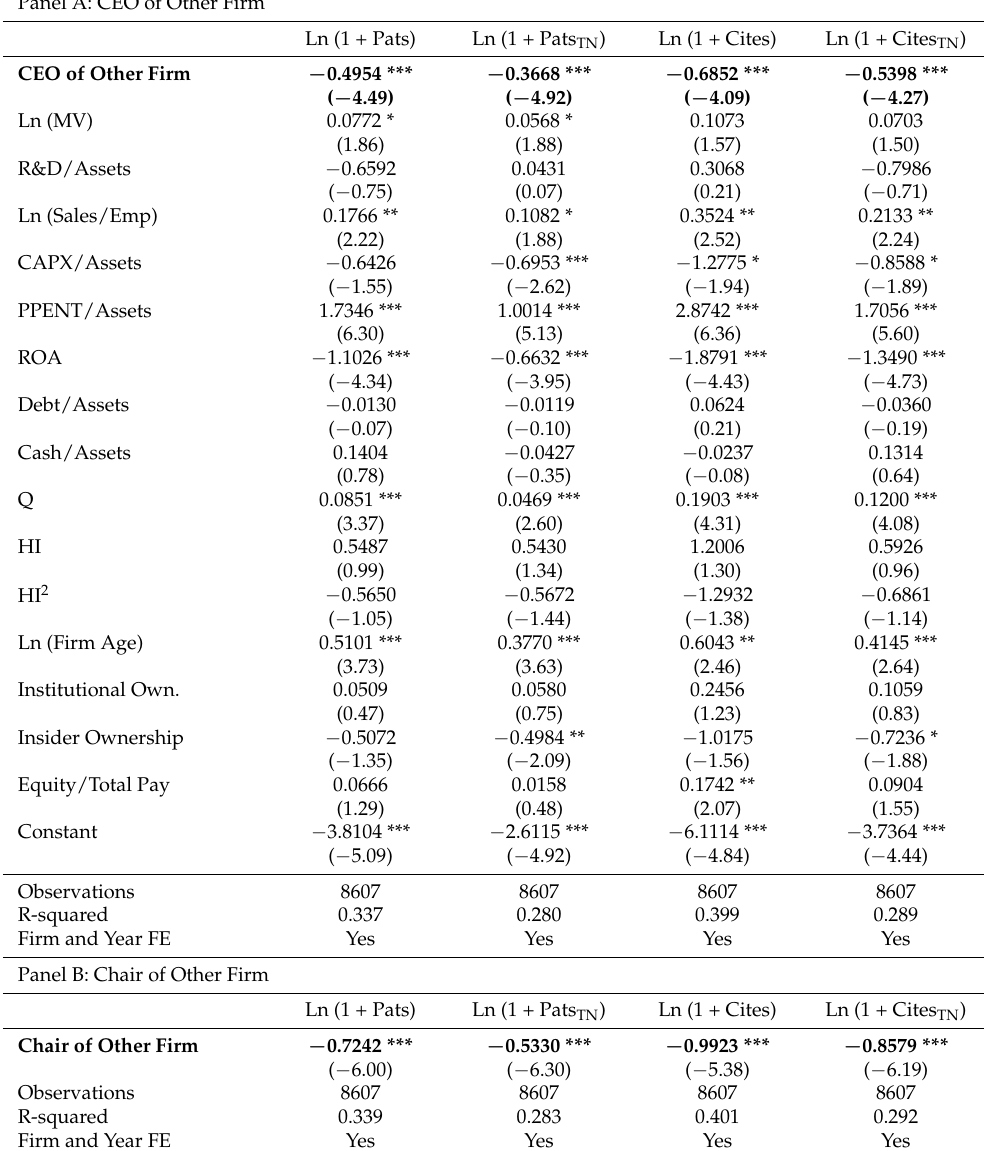
Table 7. Regressions of Innovation on Director Experience. This table presents regression results of Innovation on various measures of Director Experience. Panel A examines CEO of Other Firm, defined as an indicator variable that equals one if the board has any outside directors whose primary job title includes CEO; Panel B examines Chair of Other Firm, defined as an indicator variable that equals one if the board has any outside directors whose primary job title includes Chairman of the Board; Panel C examines Financial Expertise, defined as the percentage of directors who can be classified as a Financial Expert, per Sarbanes–Oxley; and Panel D examines Director Age, defined as the average age of directors on the board. Control variables are omitted for brevity in Panels B, C and D. All regressions contain firm and year fixed effects. All except binary variables are winsorized at the upper and lower 1% levels. Full variable definitions are provided in the Appendix A. T-statistics are reported in parentheses. Standard errors are adjusted based on the Huber–White sandwich estimate of variances and are clustered by firm. *** indicates significance at the 1% level, ** 5% and *